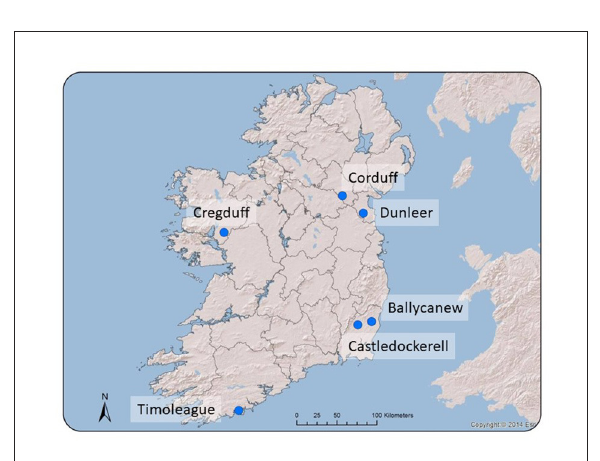
FIGURE2 Location of the six study catchments within the Irish Agricultural Catchments Programme.